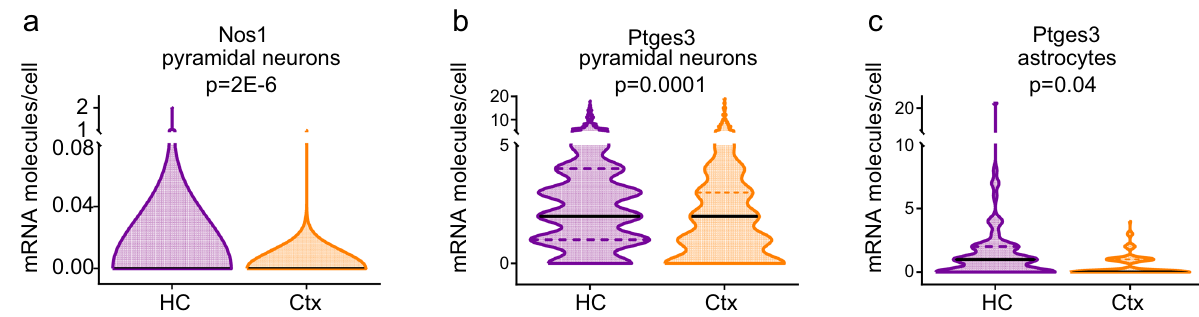
Fig. 4 Vasodilatory second messenger pathways in HC and cortex. The expression of a Nos1 and b Ptges3 were higher in the pyramidal cells of HC (941 cells) than cortex (398 cells). c Ptges3 expression was also higher in astrocytes in HC (80 cells) than V1 (143 cells). Horizontal lines on violin plots show median and interquartile range. P values represent the result of independent sample t tests, with Holm – Bonferroni corrections for the multiple comparisons presented in each of Supplementary Tables 1 –